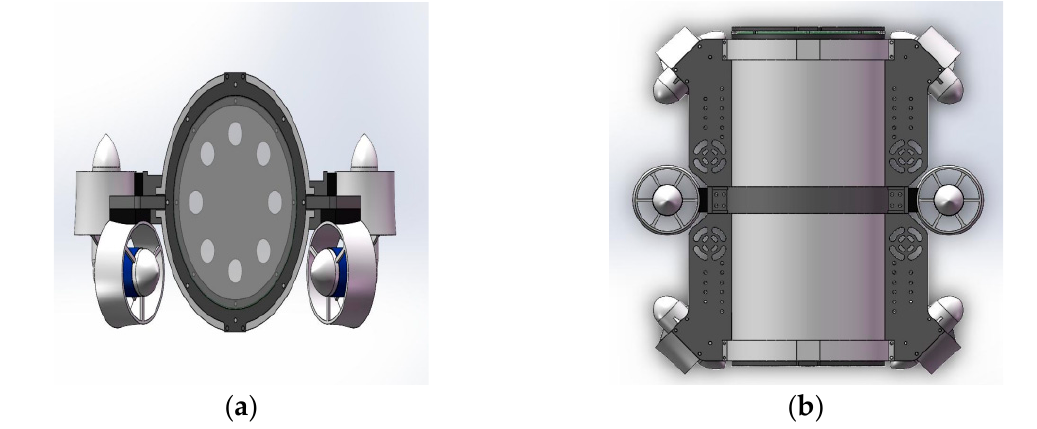
Figure 3. CAD model of UUV with six thrusters. ( a ) Front view. ( b ) Top